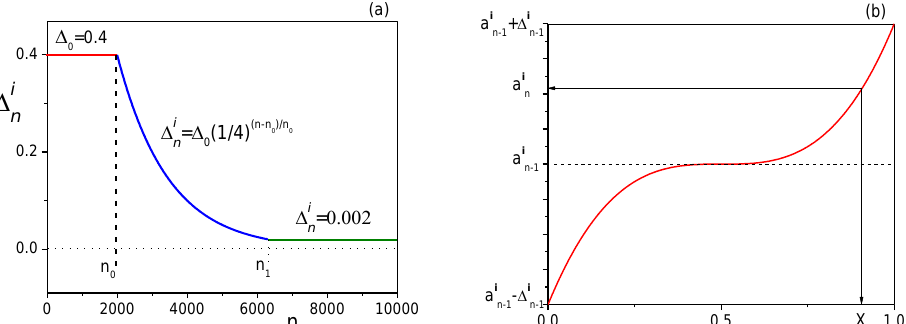
Figure 4. ( a ) Half-breadth of the parameter interval, ∆ i n , as a function of the number of iterations, n . Up to the first n o steps (horizontal red line), ∆ i n stays constant. Between the steps n o and n 1 , ∆ i n decays exponentially (blue line). Beyond n 1 , ∆ i n stays constant (horizontal green line). ( b ) Schematic drawing of the parameter values a i n vs. the random generated number, x i n , in the biased cubic probability function used in the special MC algorithm.